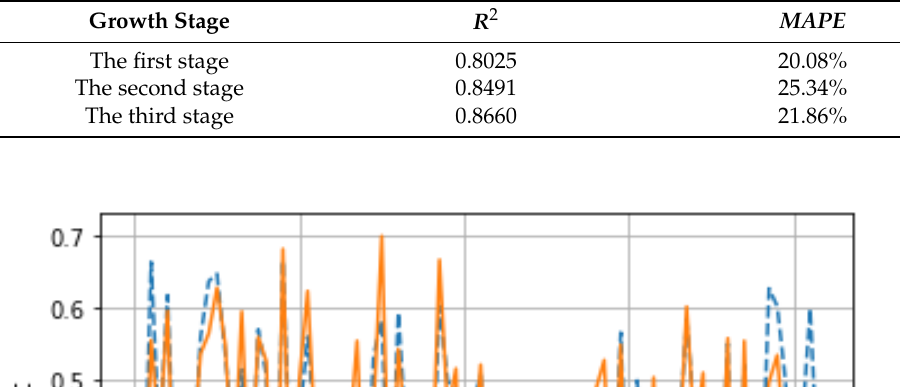
Table 13. R 2 and MAPE for the SVR plant height model.